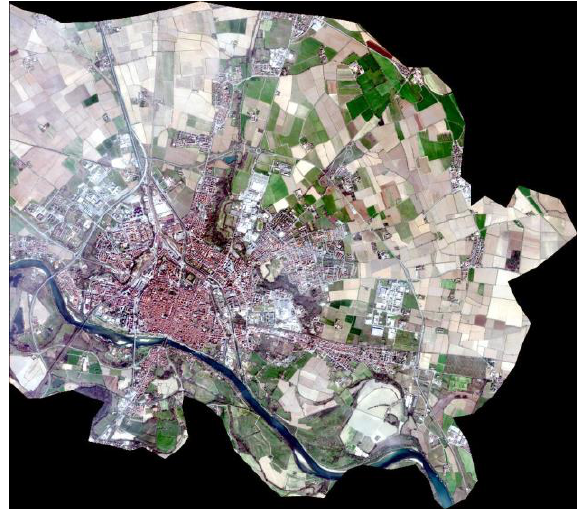
Figure 1. Entire area acquired by the WorldView3 satellite. The complete image shows the whole city of Pavia (Figure 1) but has been divided into 4 smaller pieces. The study area is in the portion highlighted by the red rectangle in the lower right portion of the entire area (Figure 2) and contains both rural and urban elements. The presence of both zones, rural and urban, was specifically chosen to evaluate several types of segmentation and classification in both situations and to choose the most effective for each of them.